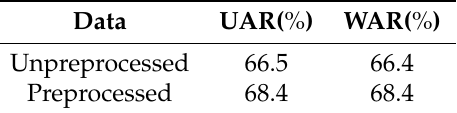
Table 2. Comparison between preprocessed and unpreprocessed data. The unpreprocessed noisy data and the preprocessed data are fed into S-STGCN respectively to compare their performance.